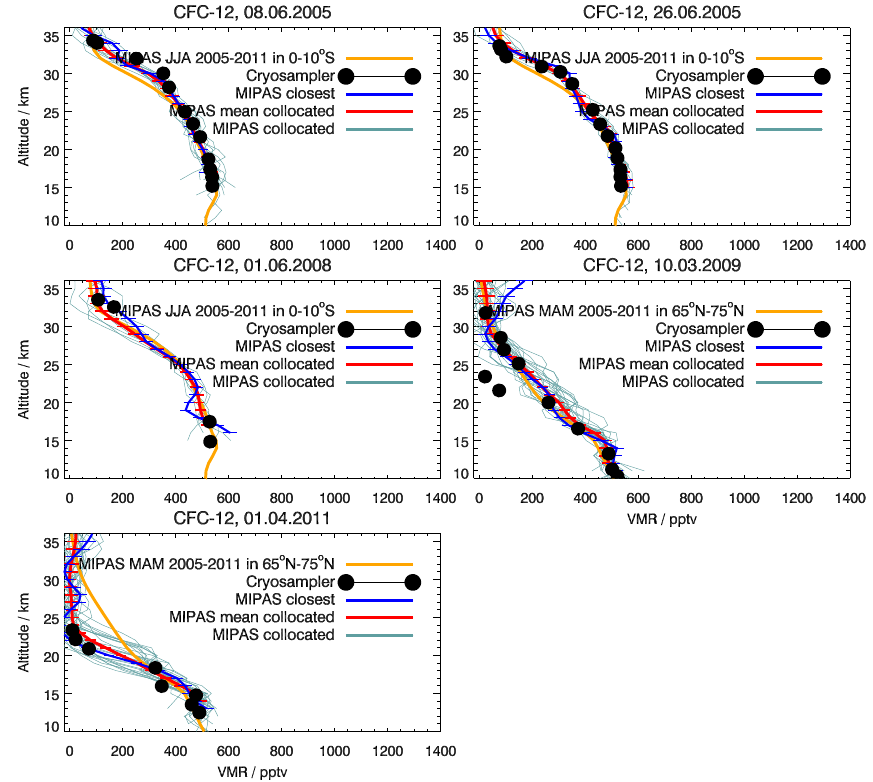
Figure 16. Comparison of an ensemble of MIPAS CFC-12 measurements (light orange lines), collocated measurements (blue-grayish lines) and their mean profile (red line) and the closest MIPAS profile (blue line) with different flights of the cryosampler (black